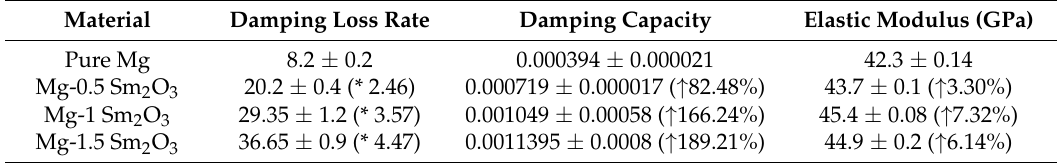
Table 5. Elastic modulus and damping characteristics of Mg-Sm 2 O 3